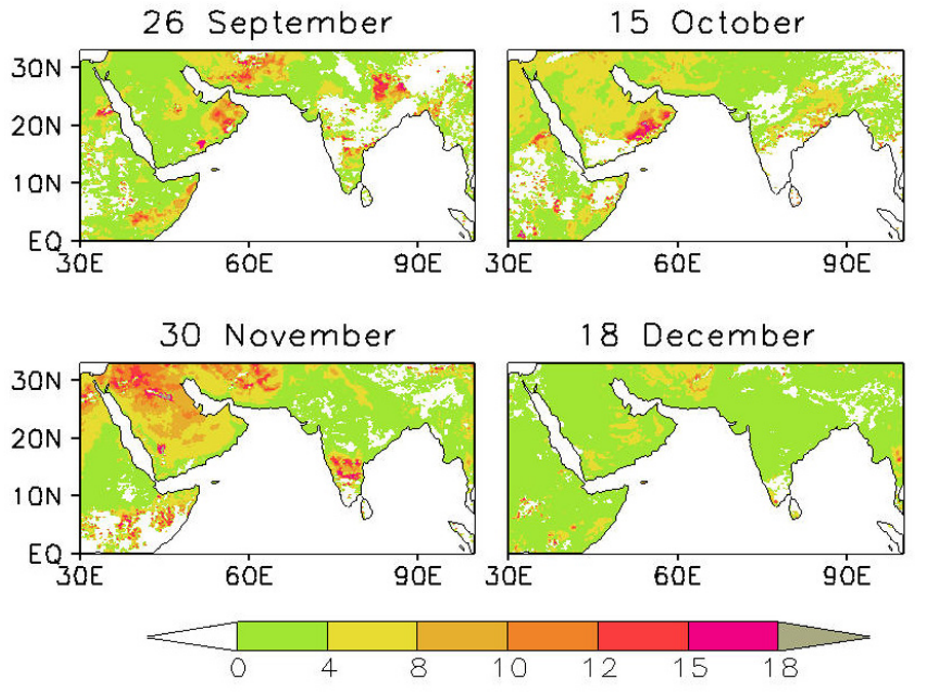
Fig. 19. Typical examples of regional distribution of IDDI (K) during September, October, November and December.